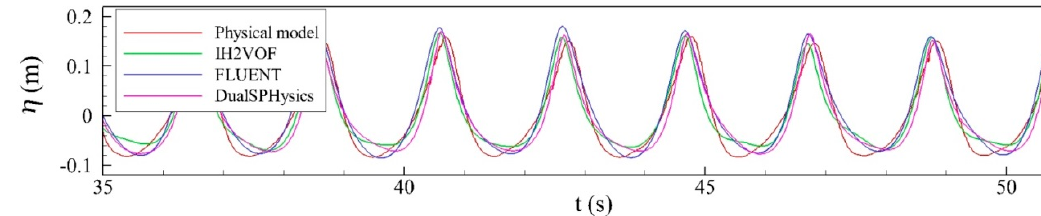
Figure 9. Time series of surface elevation for test 1 at section x = 3.0 m.